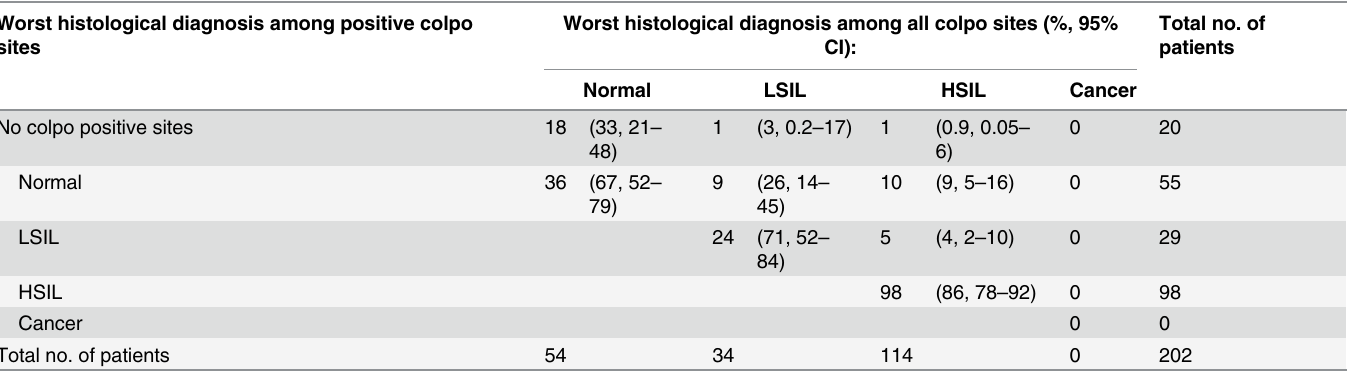
Table 8. Comparison of worst histological diagnosis among sites diagnosed as positive by colposcopy with worst overall histological diagnosis for the 202 Vancouver diagnostic patients with a positive study Papanicolaou smear diagnosis. Worst histological diagnosis among positive colpo